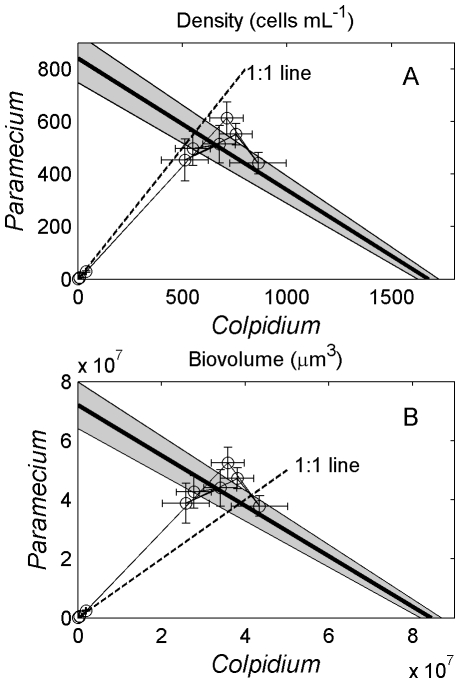
Population dynamics of Colpidium striatum and Paramecium aurelia in state-space.Plots show mean and standard errors of density (A) and biovolume (B). Both steady-states were centered along the RYT, which is a straight line connecting the steady-states of each species when alone. The gray shaded area along the trade-off perimeter is the 95% confidence intervals of the perimeter, as determined by the 95% CIs of the steady-states. Steady states that occur along this line when grown together indicate that the species are trading-off against each other in both density and biovolume, rather than gaining a boost in numbers of biovolume (over yielding) when grown together.